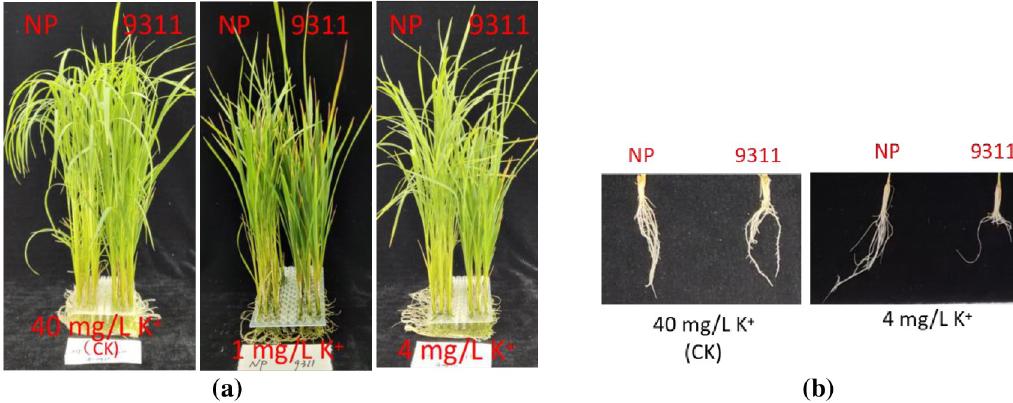
Fig 6. Phenotypic differences between NP and 9311 treated with low potassium (1, 4 mg/L K + ) and common potassium (40 mg/L K + ) medium. a: Plant growth state; b: Root state of the plant.